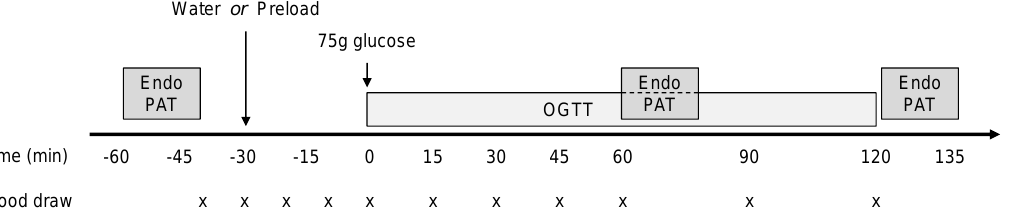
Figure 1. Outline of the study protocol. Endothelial function was assessed by the reactive hyperemia index (RHI) using an EndoPAT device at fasting, 60 min and 120 min during two 75 g oral glucose tolerance tests (OGTTs) preceded by water or a protein/lipid preload. Plasma glucose, insulin, glucagon-like peptide-1 (GLP-1), glucose-dependent insulinotropic polypeptide (GIP), glucagon, free fatty acids, and amino acids were measured.